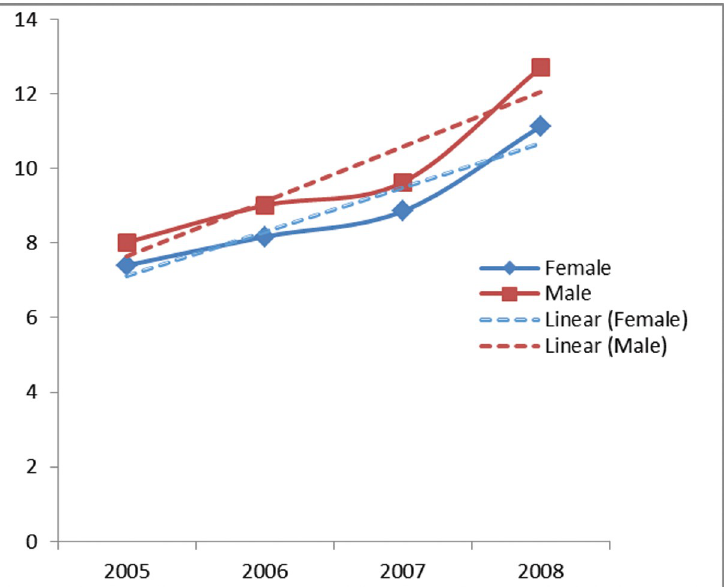
Fig 1. Age standardized rate of colorectal cancer incidence and its trend for male and female in Iran (2005–2008).